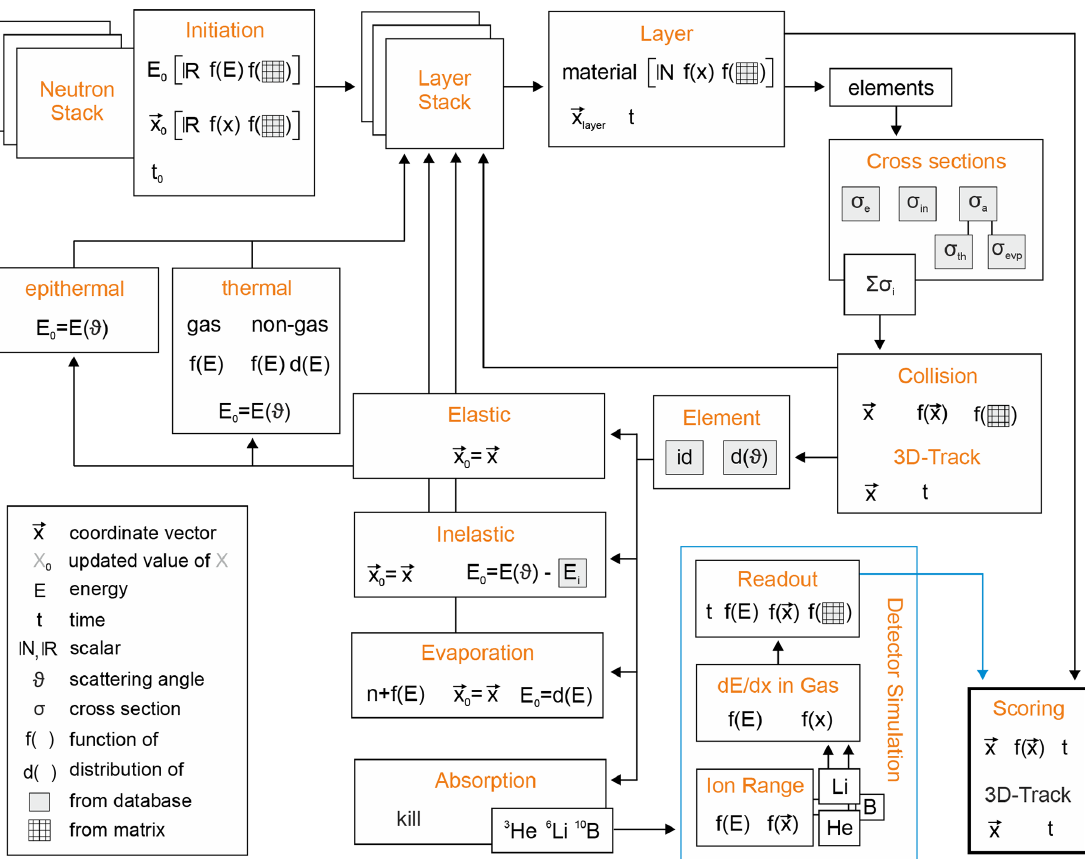
Figure 2. Internal workflow of URANOS. Each calculation step is represented by a block describing the structural function in orange and the corresponding physics variables.